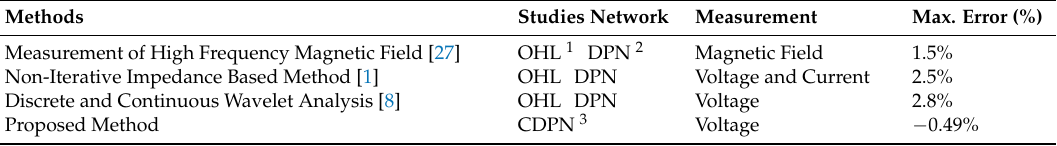
Table 7. Comparison of the previous studies with the proposed